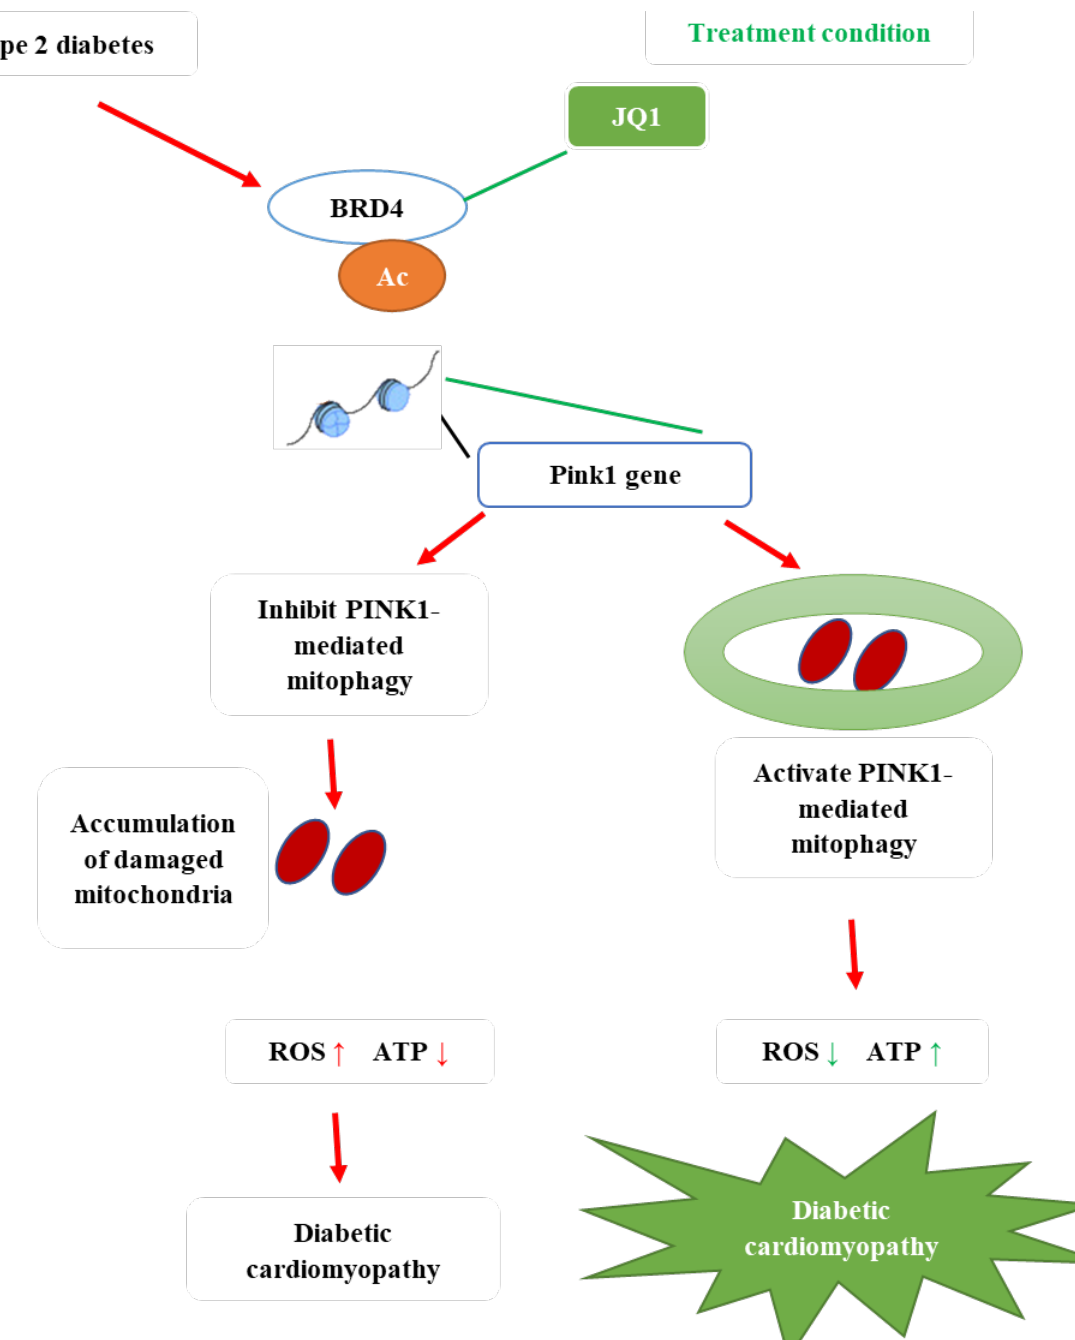
Figure 4. The schematic diagram of PINK1/Parkin-mediated mitophagy (adapted from [101]